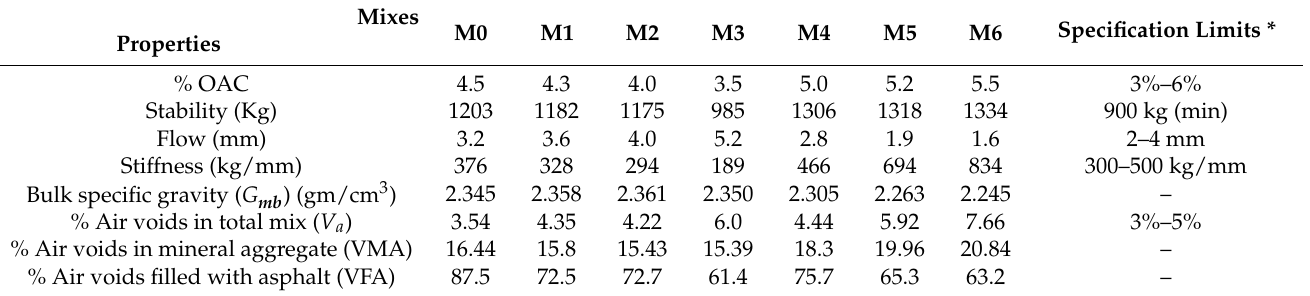
Table 4. Effect of aggregate gradation variation on the investigated